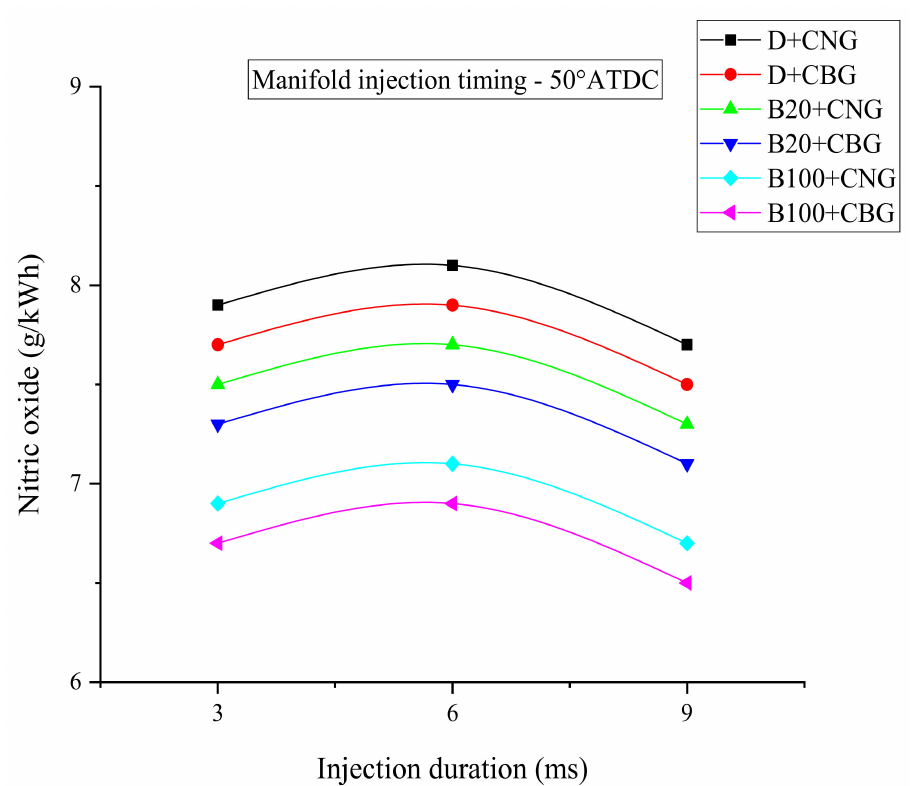
Figure 12. Variation of NOx emissions with